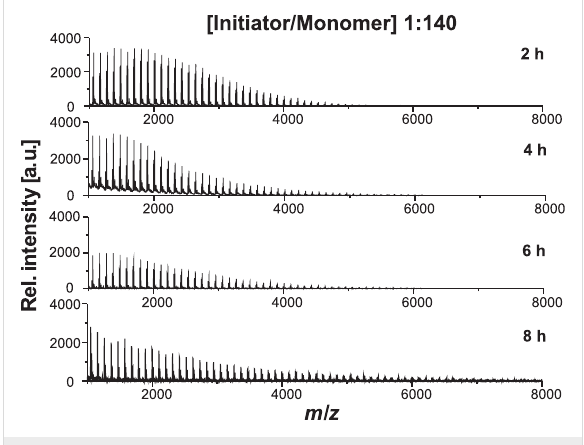
Figure 4: MALDI-TOF MS of P2VP obtained for polymerizations stopped after 2, 4, 6, and 8 h. The samples were prepared by the dried droplet method dissolving the polymer, DT, and KOTf in THF. To gain representative information, the spot was probed at several locations and 100 spectra were